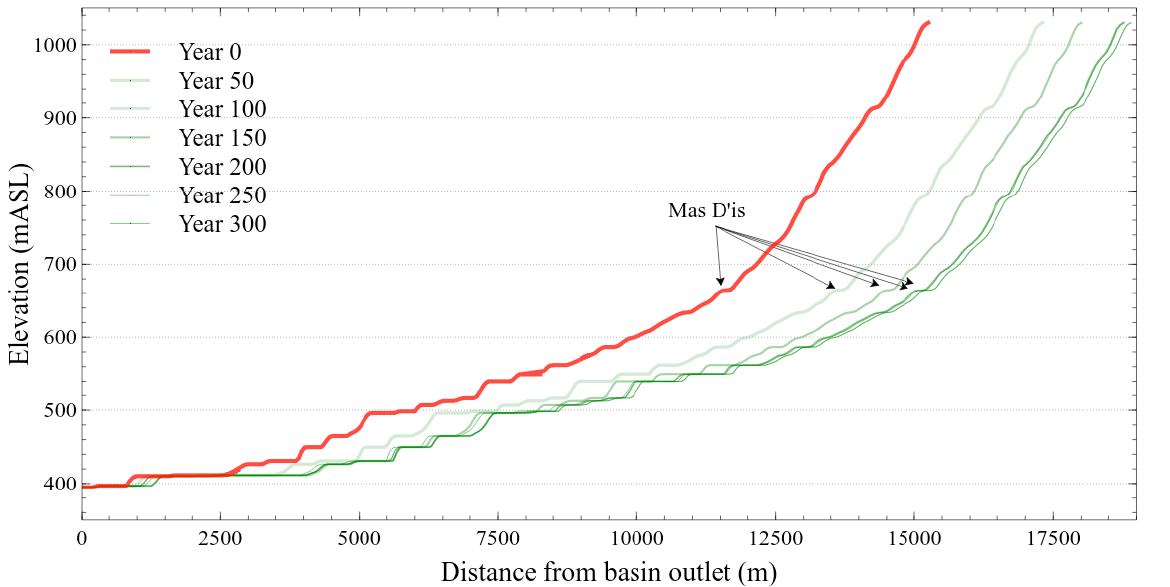
Figure 8. The longitudinal profile of the main watercourse near Mas d’Is (see Figure 2). The red line indicates the profile as extracted from the starting reconstructed mid-Holocene topography. The green lines show the profile in 50-year increments during one run of the maximizing large-population experiment. The overall length of the profile increases over time due to changes in channel morphology (such as the growth of meanders and lateral incision). The profile also becomes more graded over time, although erosion seems to occur mainly in punctuated stretches of the channel